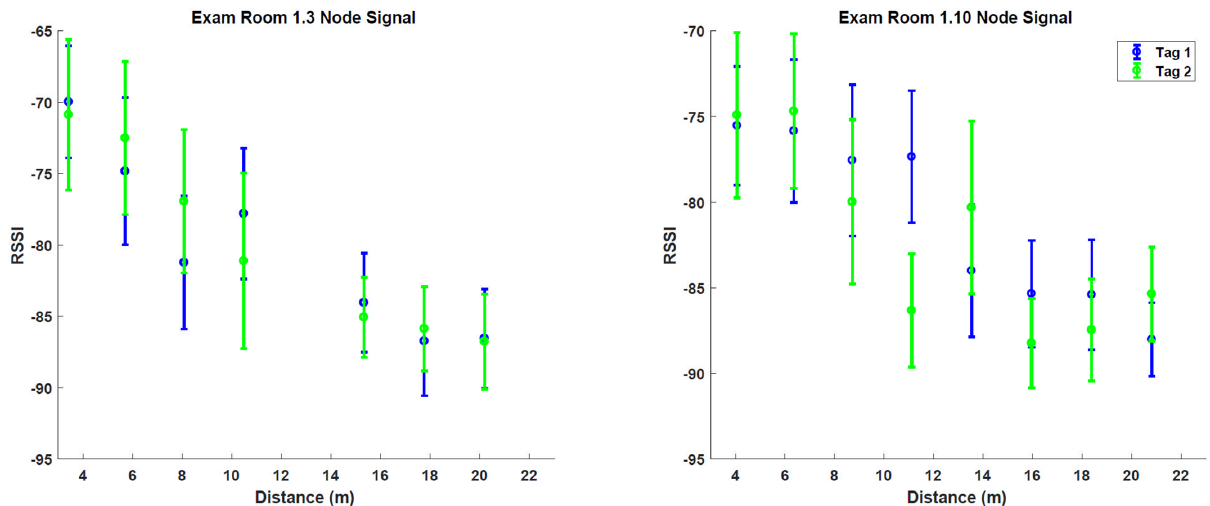
Fig 2. Signal intensity as a function of distance from node. The relative received signal strength (RSSI) is shown as a function of distance from the node. Two RadBeacon Dot (Radius Networks) tags were tested in two different exam rooms, and both show decreasing signal strength as the tags are placed further from the Raspberry